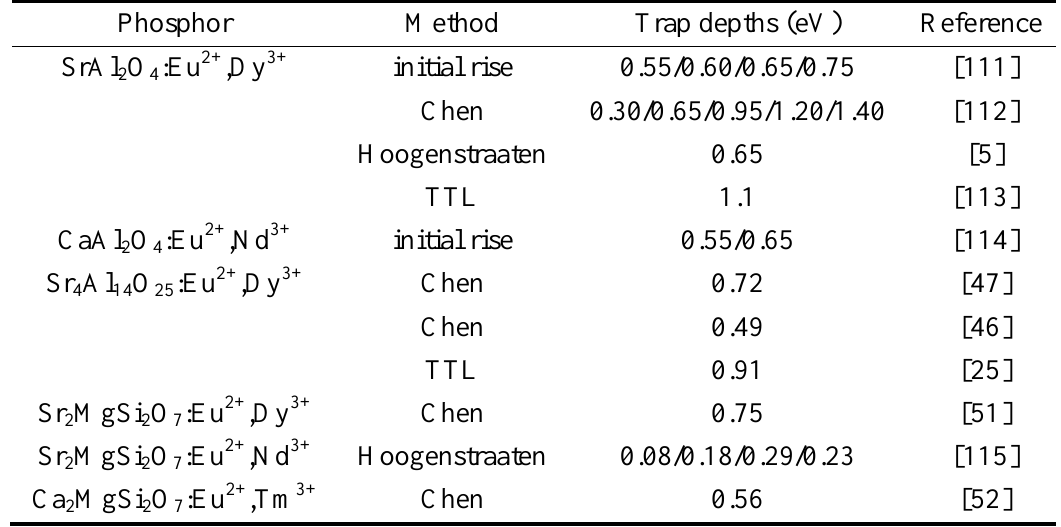
Table 4. Estimated trap depth(s) in some of the best-known persistent luminescent